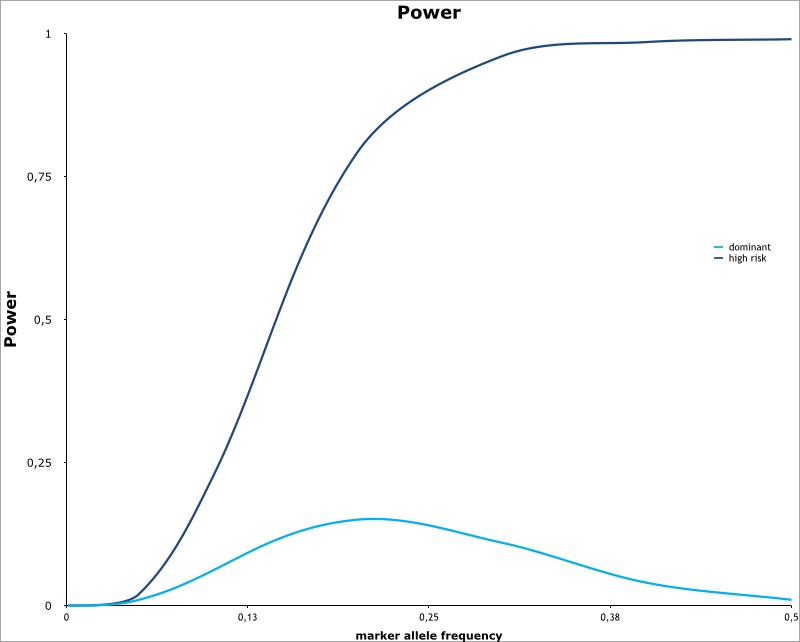
Power of the study.